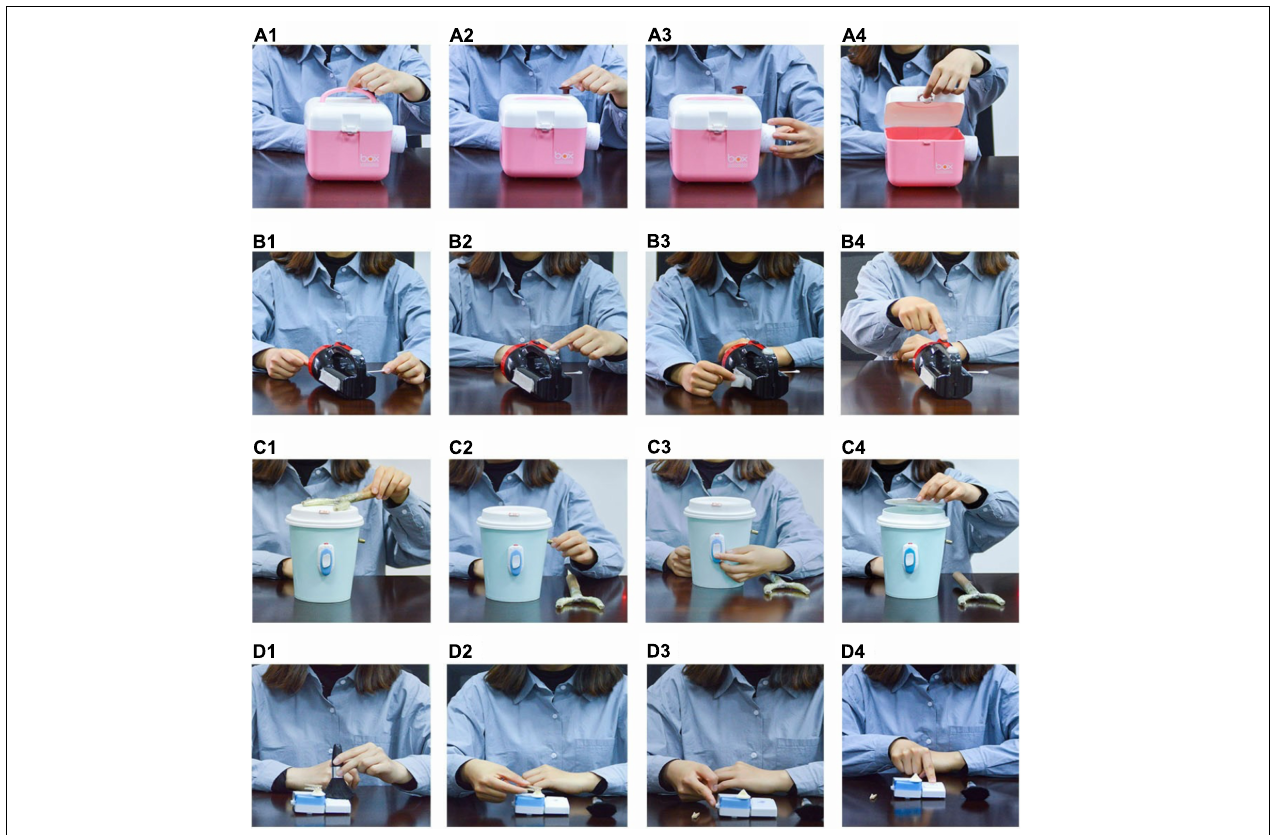
FIGURE 2 | Photographs of the four test objects (shown as the rows A1–D4 ). Within each row, photos show the three arbitrary target acts (Acts 1–3, in each row) and the outcome act that leads to a salient outcome (Act 4, in each row). See also Figure 1 and main text for more